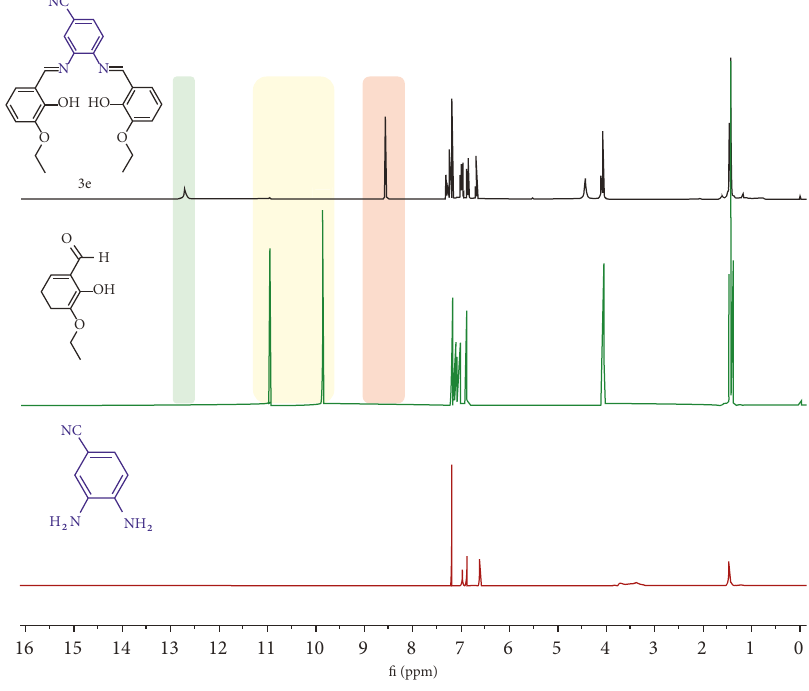
Figure 1: 1 H NMR Spectra of diamine, aldehyde, and Salophen ligand.